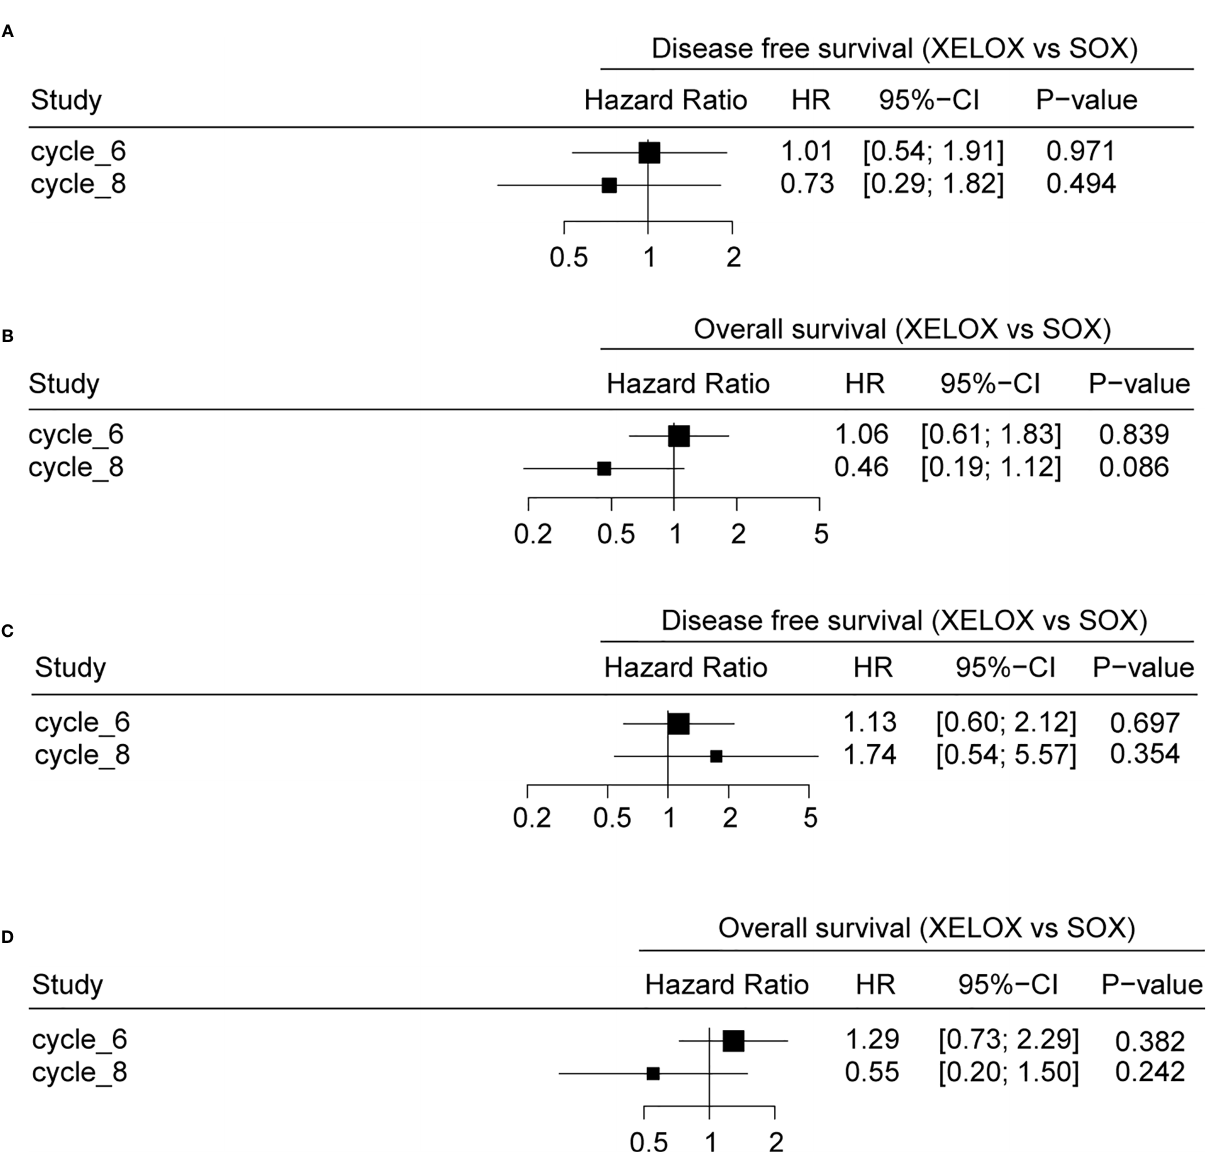
FIGURE 5 | The relationship between different chemotherapy cycles and disease-free survival (DFS) and overall survival (OS) of gastric cancer patients. DFS (A) and OS (B) analyses for patients with stage II and stage III gastric cancer. DFS (C) and OS (D) analyses for stage patients with stage III gastric